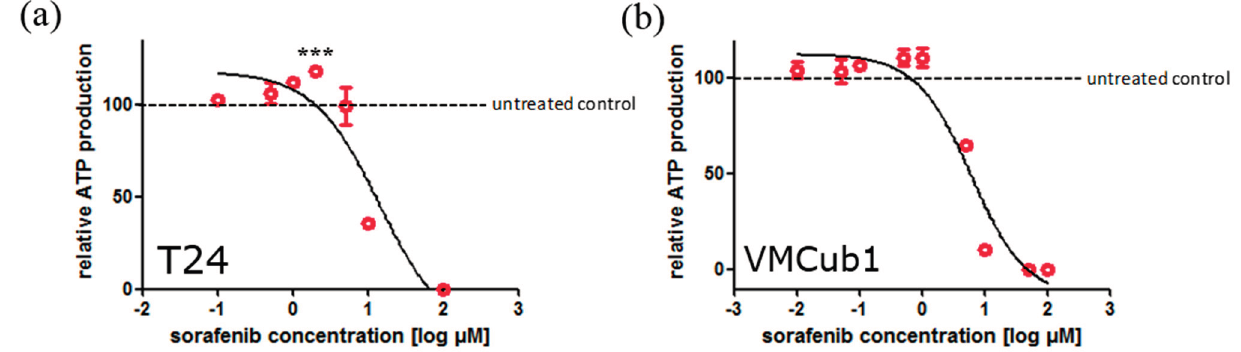
Figure 2. Dose-dependent effect of sorafenib on cell viability as measured by total ATP levels in ( a ) T24 and ( b ) VMCub1 cells. In T24 cells, a statistical significant increase of cell viability was observed at a concentration of 2 µM sorafenib ( *** p < 0.05, Dunnet’s multiple comparison